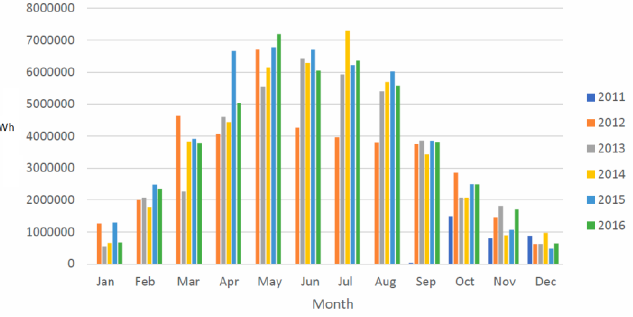
Figure 5. Energy production over the years.